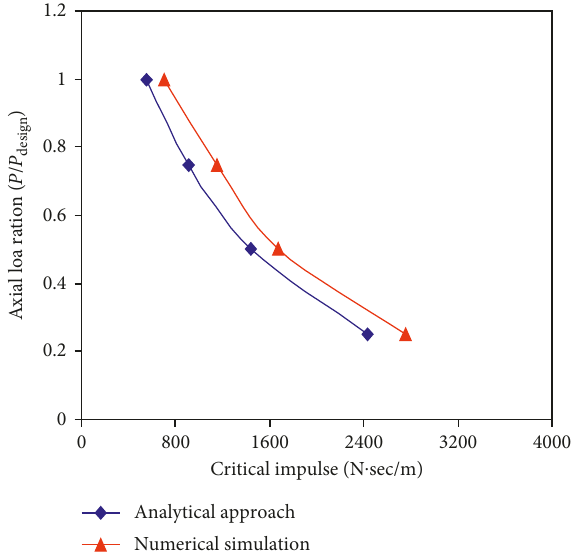
Figure 27: Comparison between analytical method and ABAQUS predictions of critical impulse-axial force curve for simply sup- ported steel column section W200 71 with blast pressure to cause × bending about major axis of the